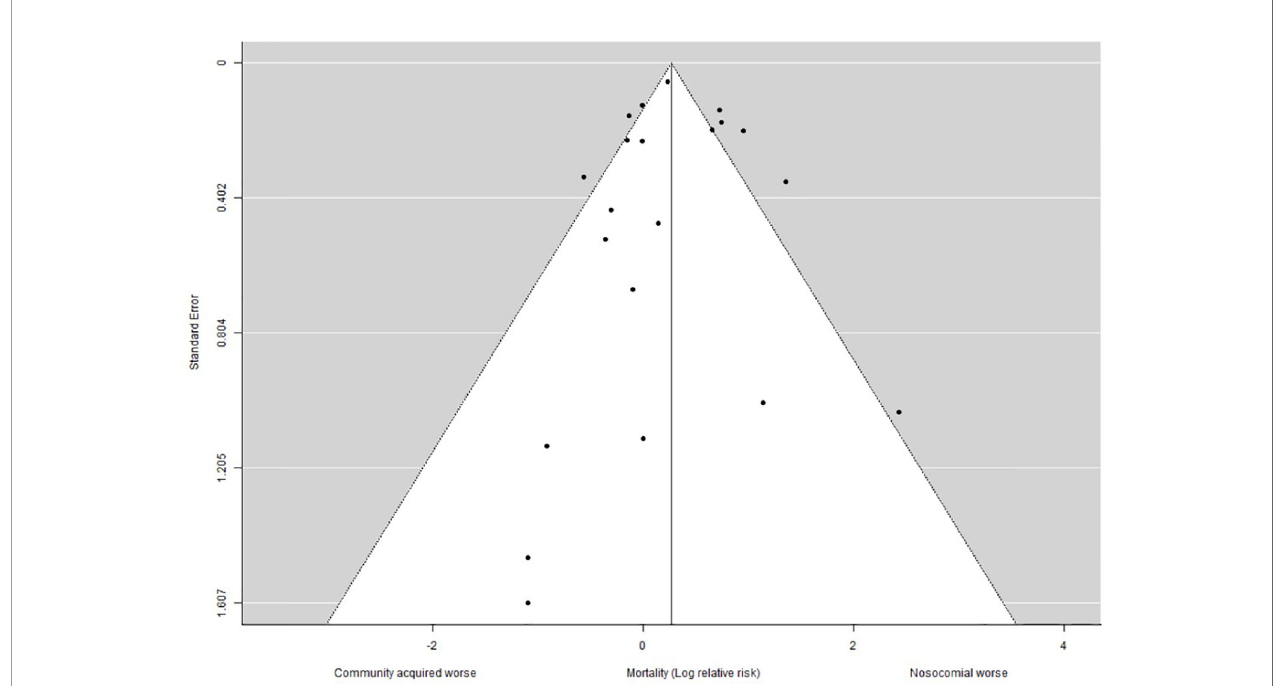
FIGURE 5 | Funnel plot. Funnel plot with pseudo 95% con fi dence limits showing the distribution of relative risk of mortality across individual studies. Egger ’ s test, p = 0.51.